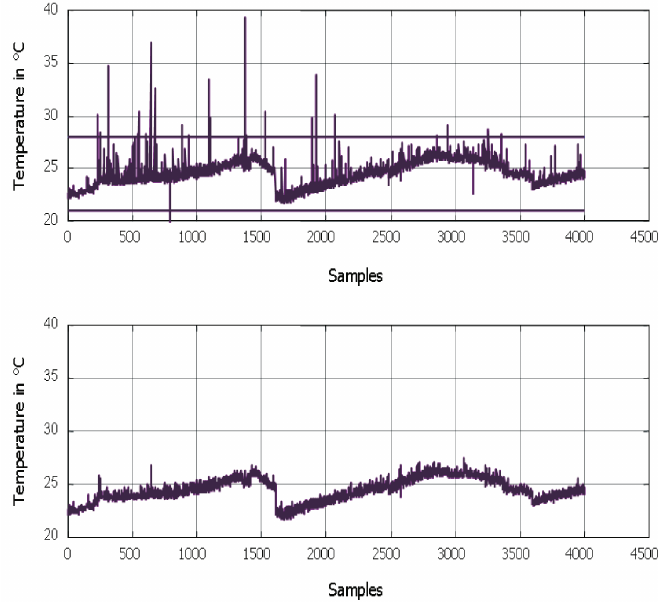
Figure 2. Example of contaminated temperature measurements. With outliers (top) and minimum, maximum limits. The clean temperature data is obtained with help of GEDR.